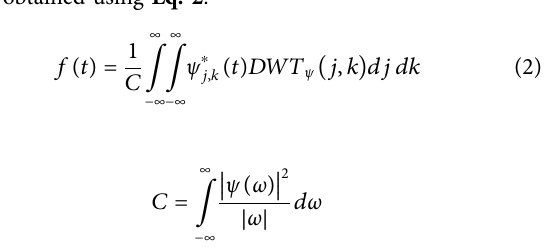
Frontiers in Signal Processing |